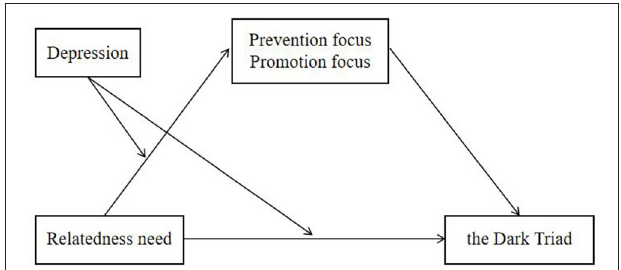
FIGURE 1 | The proposed moderated mediation